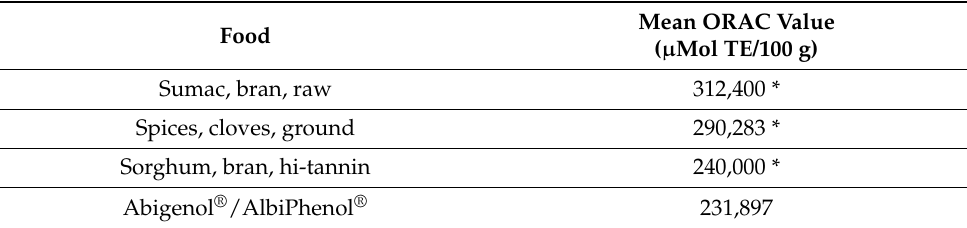
Table 4. Total-ORAC value of Abigenol ® /AlbiPhenol ® compared to those of the most antioxidant foods according to the database for the ORAC of selected foods (*) (US Department of Agriculture)